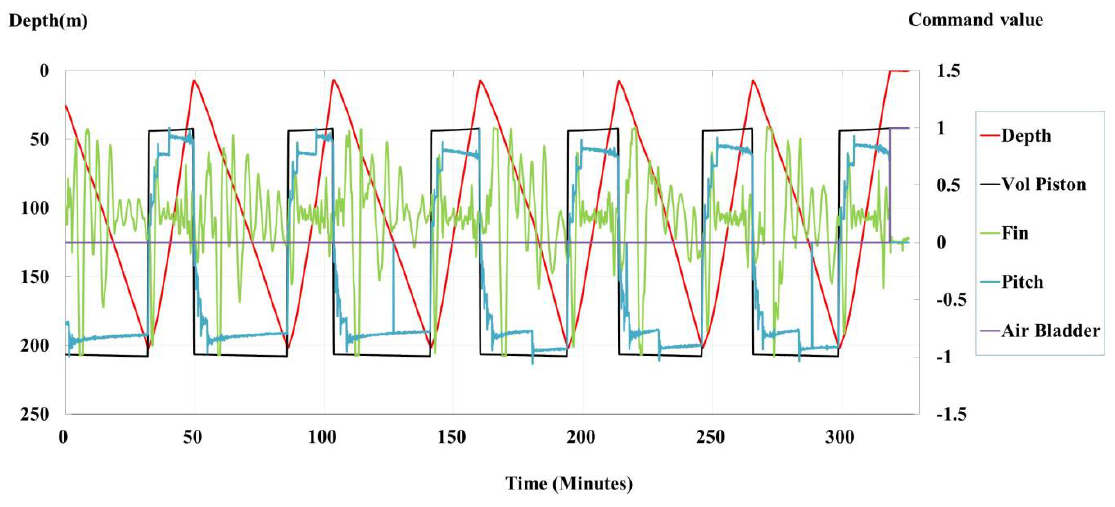
Figure 5. Command values when the glider is operating at sea.